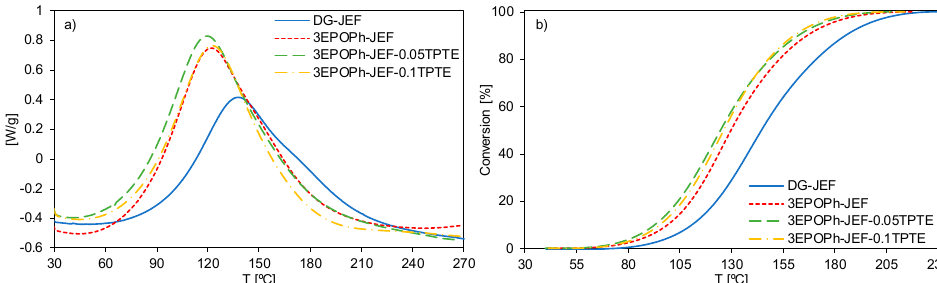
Figure 4. ( a ) Differential scanning calorimetry (DSC) thermograms corresponding to the dynamic curing at 10 °C/min of the formulations studied. ( b ) Conversion as a function of temperature of the formulations studied.